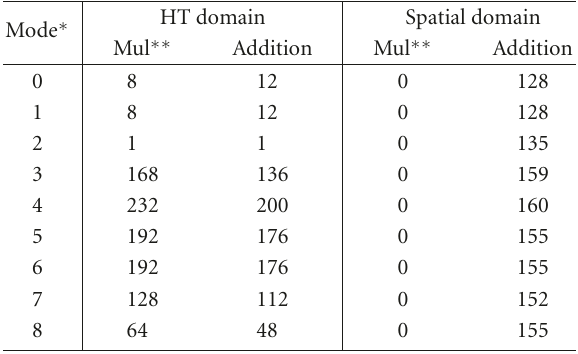
Table 8: Computation complexity of intraprediction for di ff erent